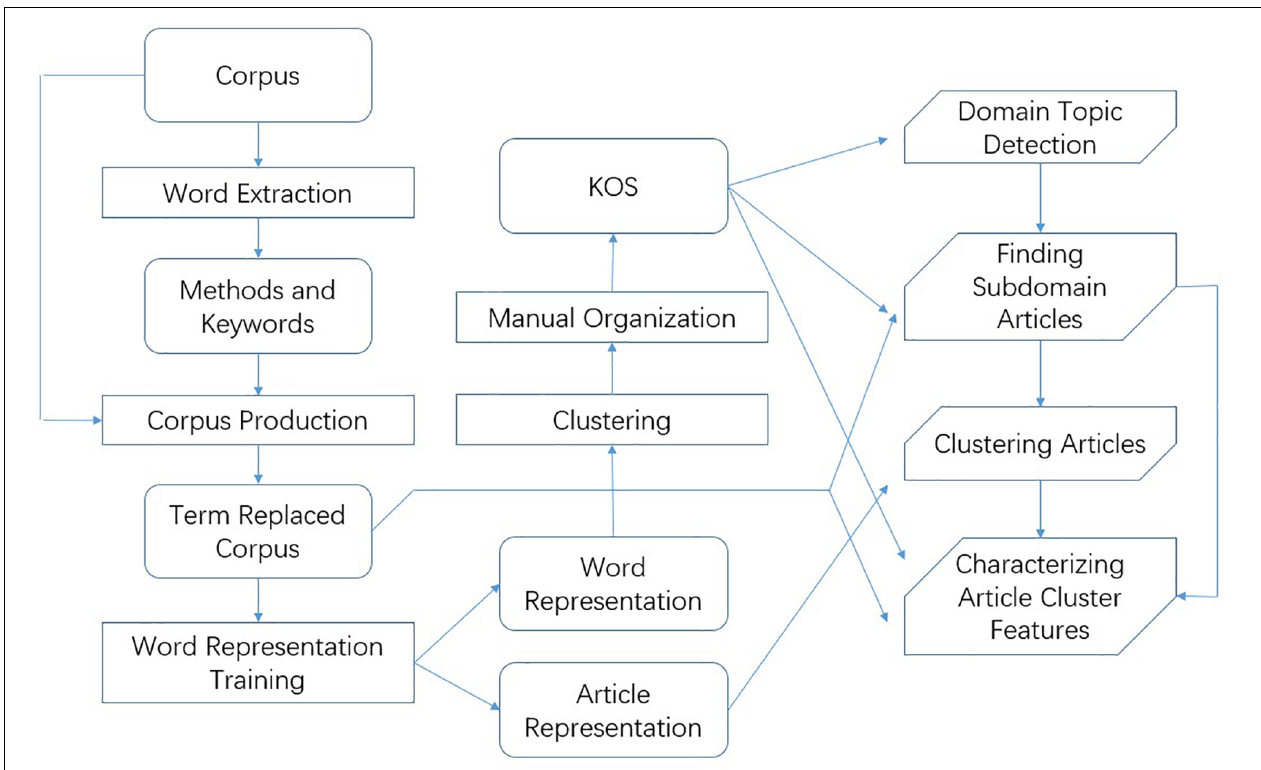
FIGURE 2 | Flowchart of the proposed